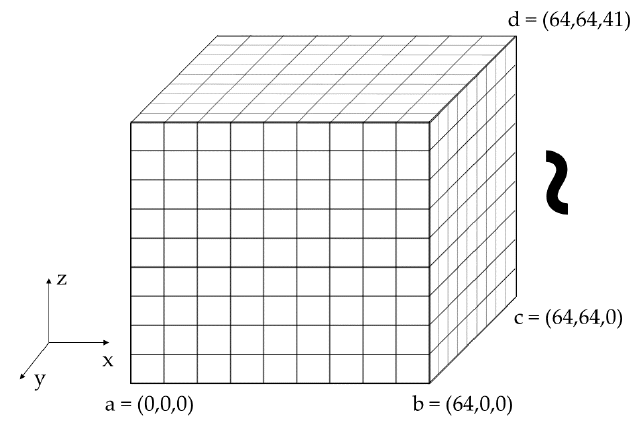
Figure 2. Schematic of the structure of the ferroelectric material used in this simulation. Each value of